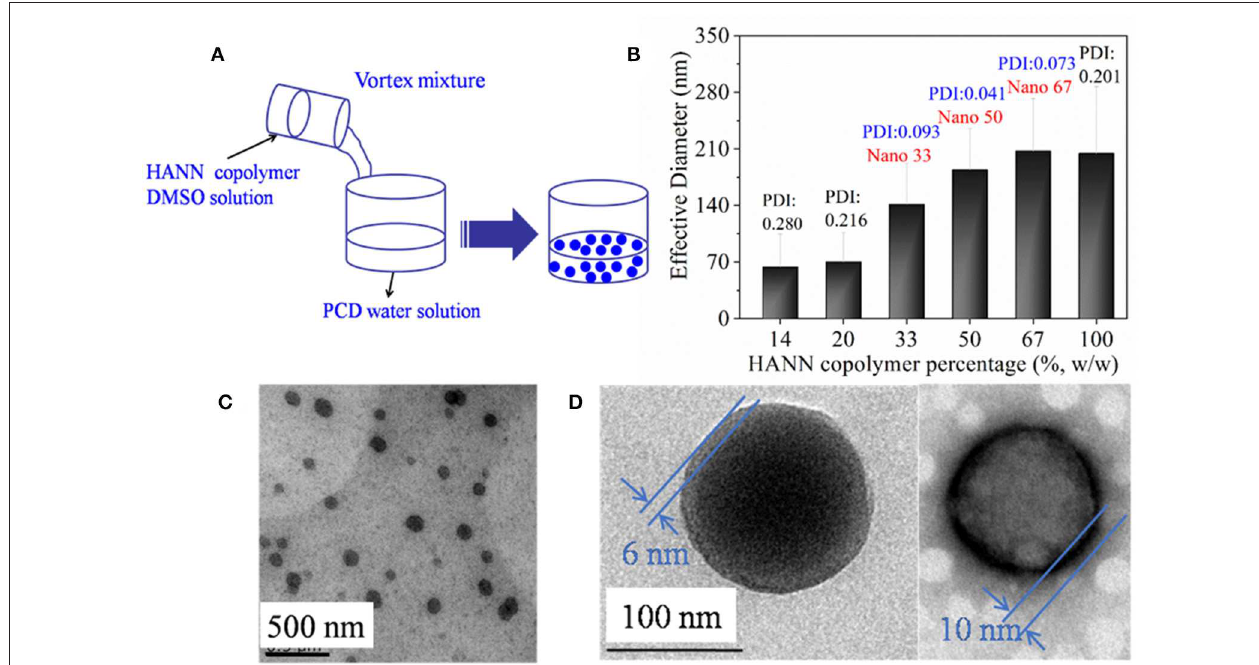
FIGURE 1 | (A) Schematic illustration to show the assembled nanoparticle formation; (B) effective diameter of nanoparticle as a function of HANN copolymer percentage. TEM images of nano 33 (C) and (D) magnified images including normal image (left) and background staining image (right).